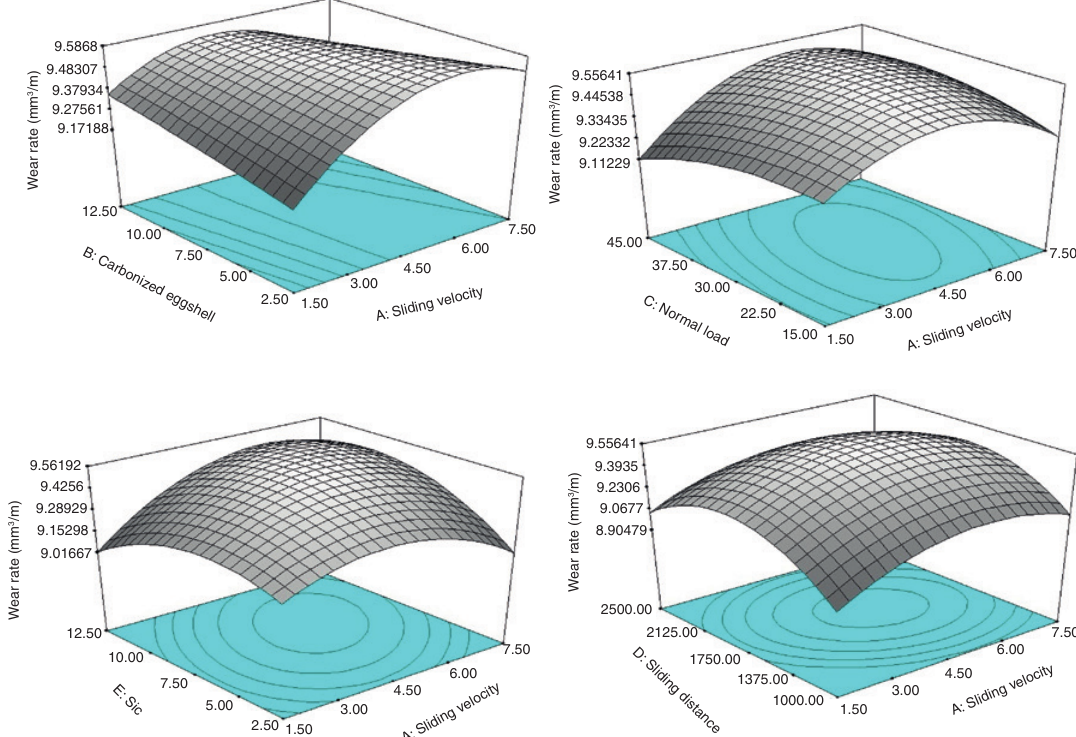
Figure 10: Interactions of sliding velocity with carbonized eggshell wt.%, normal load, sliding distance, and SiC wt.% to reduce wear rate.